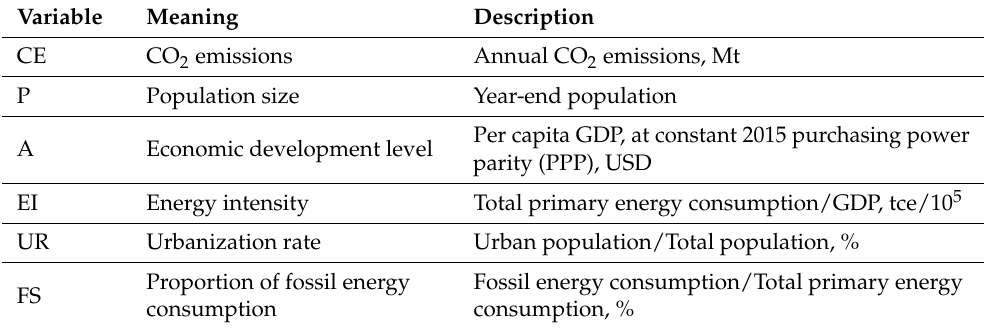
Table 1. Interpretation of